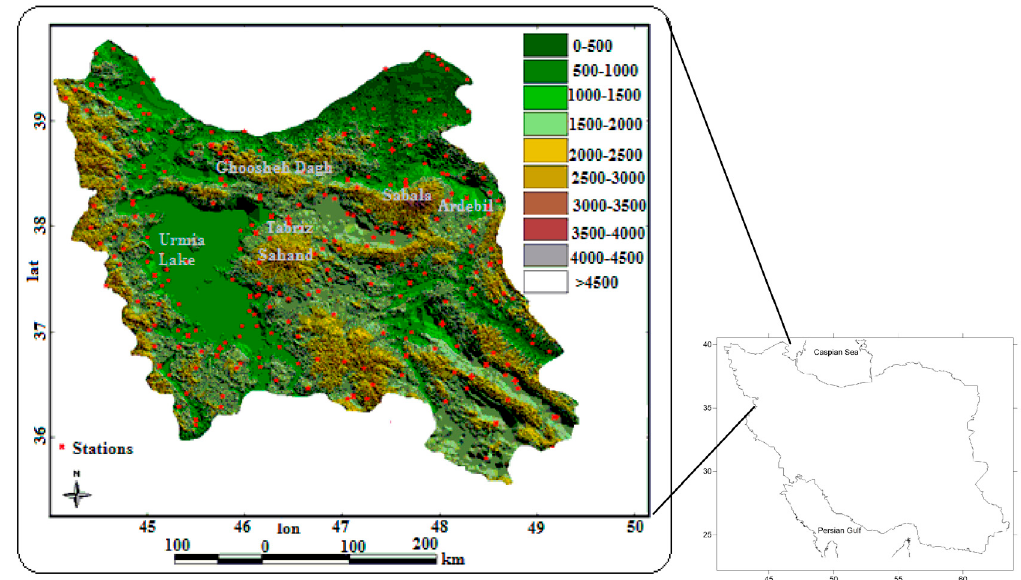
Figure 1. Height and distribution of stations in the northwest of Iran.